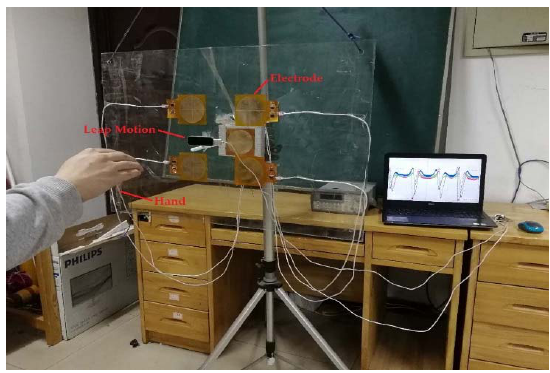
Figure 11. Experimental scene.